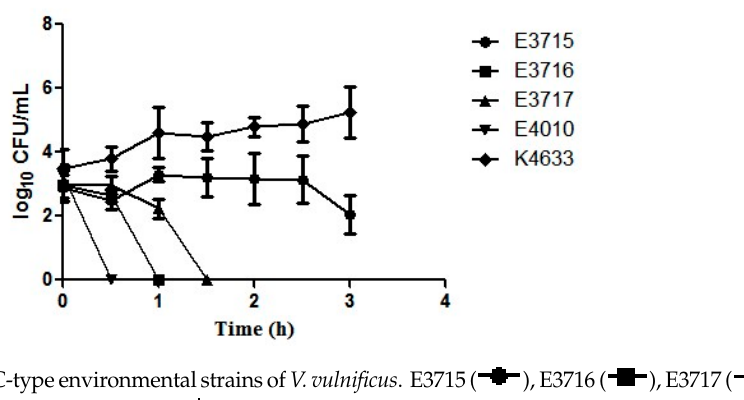
Figure 3. Survival of C-type environmental strains of V. vulnificus. E3715 ( ), E3716 ( ), E3717 ( ), E4010 ( ), and a clinical strain K4633 ( ) exposed to serum for 3 h. Error bars represent the standard error of the mean of three replicates each.